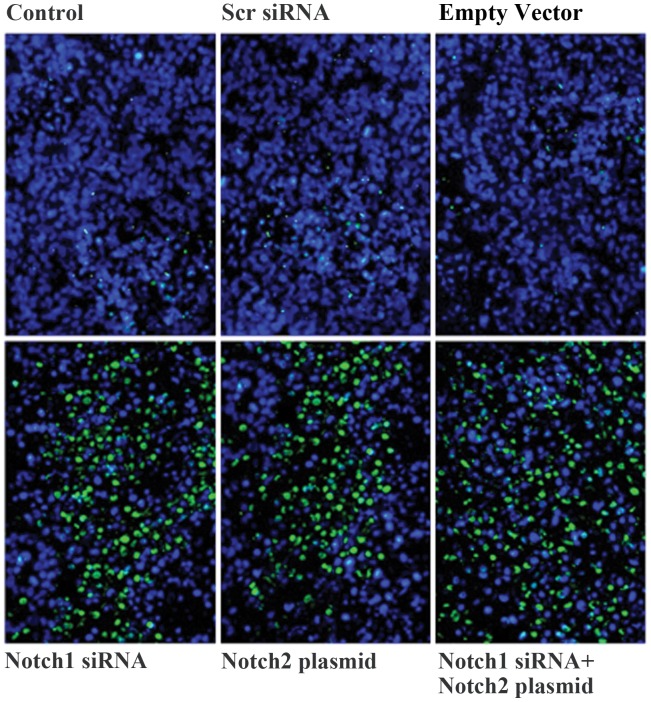
Apoptosis cells in xenograft tumors was detected by TUNEL.Apoptosis cells in xenograft tumors, tumors treated with scr-siRNA, empty vector, Notch1 siRNA, Notch2 construct and those two plus group detected by TUNEL method (×200).